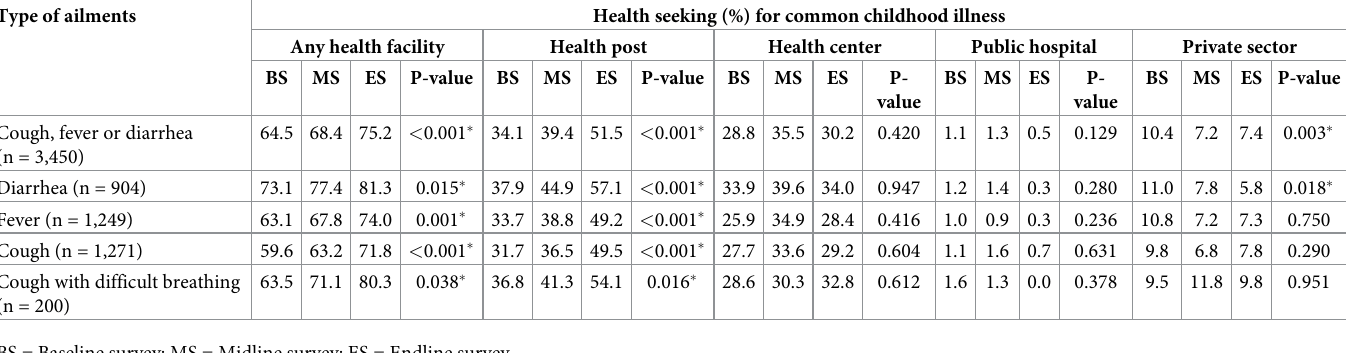
BS = Baseline survey; MS = Midline survey; ES = Endline survey � Significant positive or negative trend at 5% level of significance.